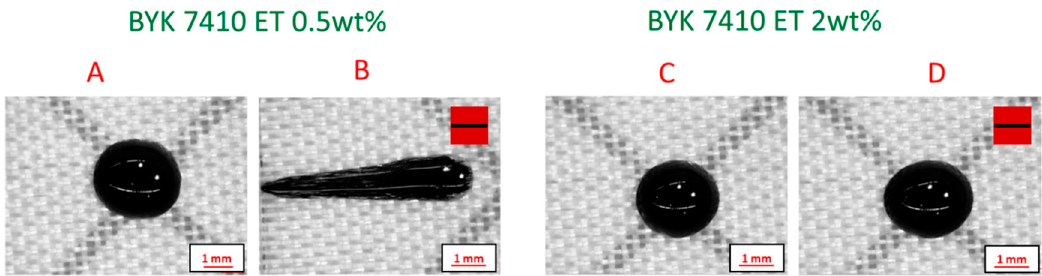
Figure 5. Droplet images, showing the influence of rheological additive loading: ( A ) and ( C ): Droplet images before magnetic field application; ( B ) and ( D ): Droplet images after field application. Red squares with a black bar indicate the presence and direction of the magnetic field.